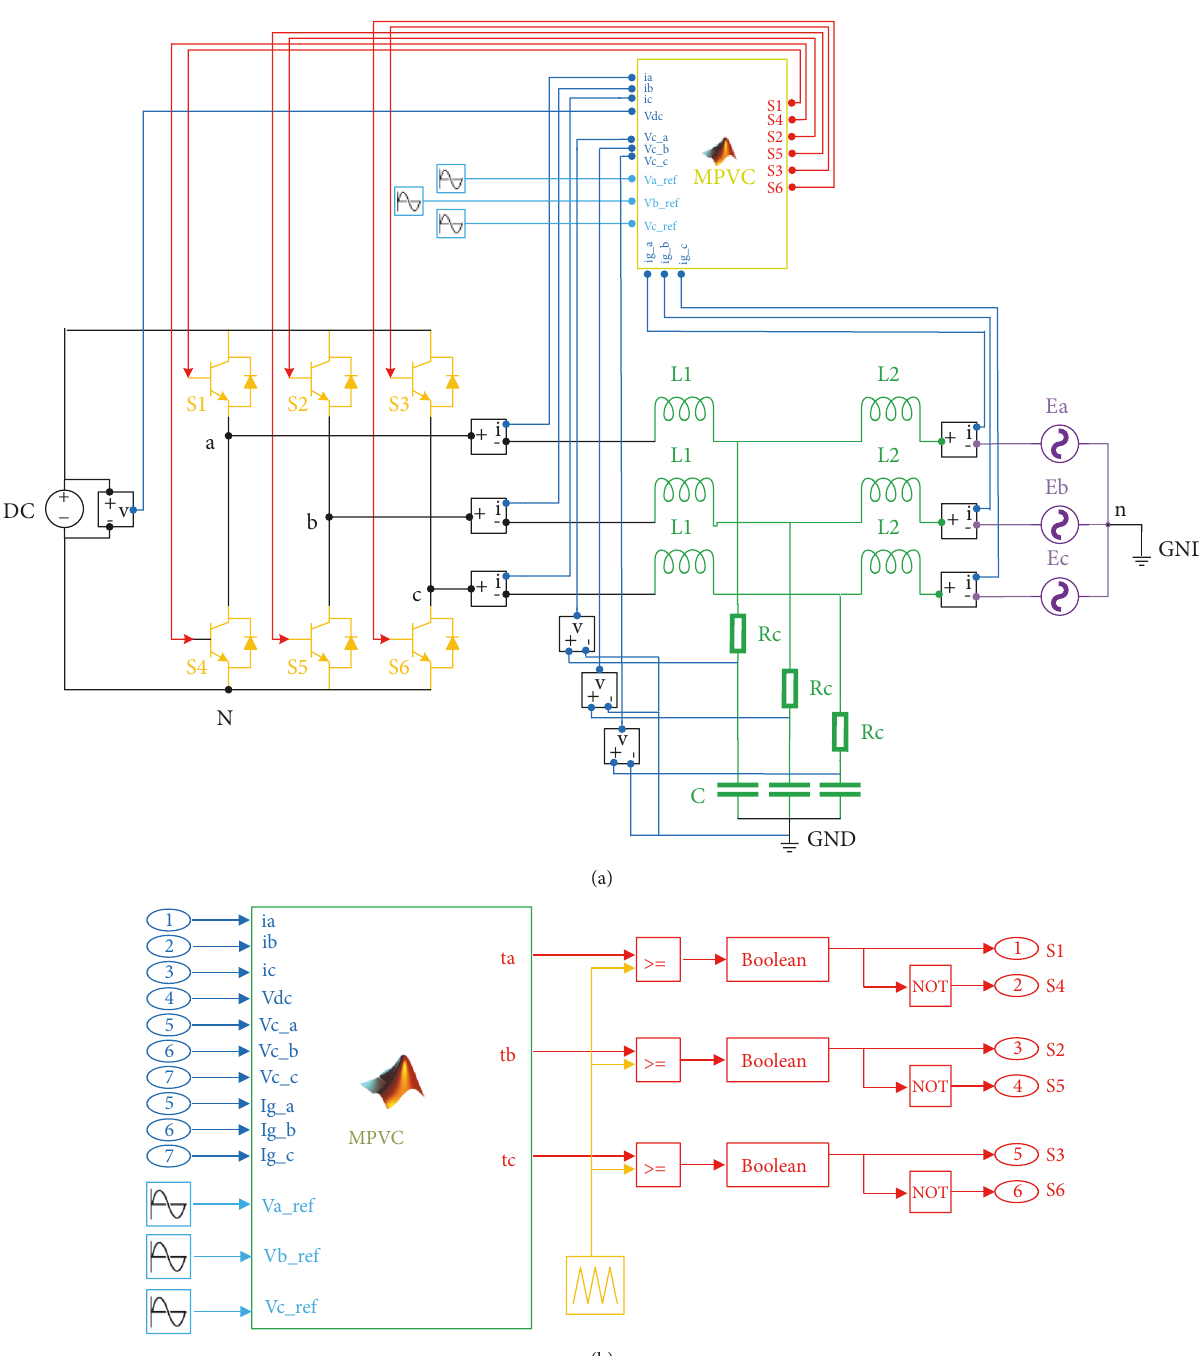
Figure 5: Simulation diagram in MATLAB/Simulink. (a) Proposed MPVC with duty cycle control for a three-phase inverter connected to the grid. (b) Subsystem of the